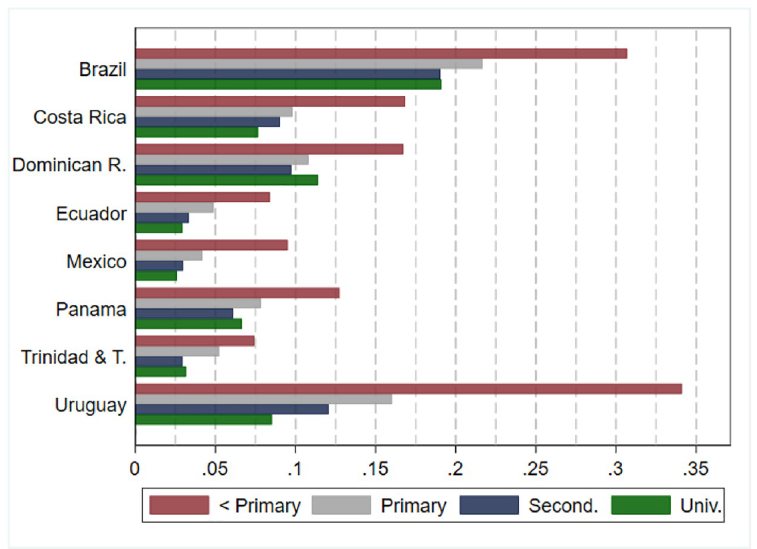
Fig 4. Prevalence of disability: Estimates by country and household head education level. Source: authors’ estimations based on data provided by [10] from censuses collected by National Statistics Offices in each country. Estimates for Brazil, Dominican Republic, Ecuador, Mexico, and Panama refer to the year 2010. Estimates for Costa Rica, Trinidad and Tobago, and Uruguay refer to the year 2011. Estimates consider individuals aged 3 years and older.